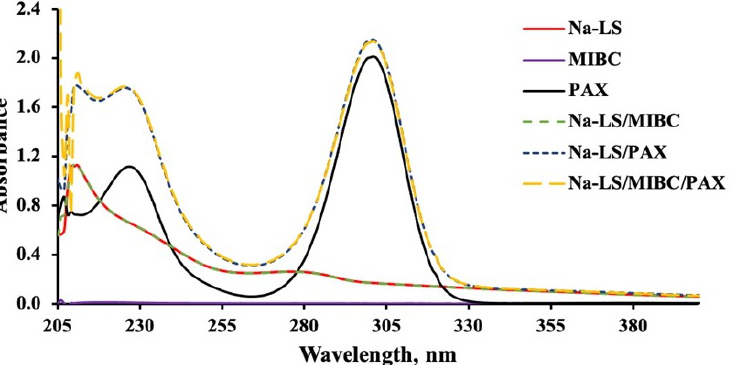
Figure 9. Absorbance spectra of Na-LS (50 ppm), PAX (25 ppm) and MIBC (15 ppm), used in flotation without contacting the mineral in